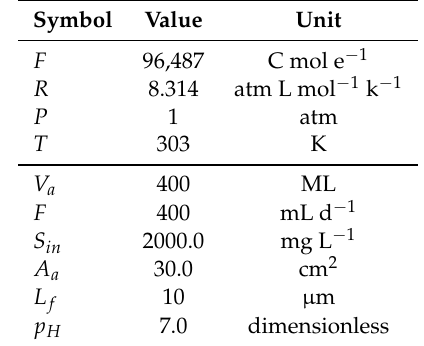
Table 2. Set of additional parameters and operating